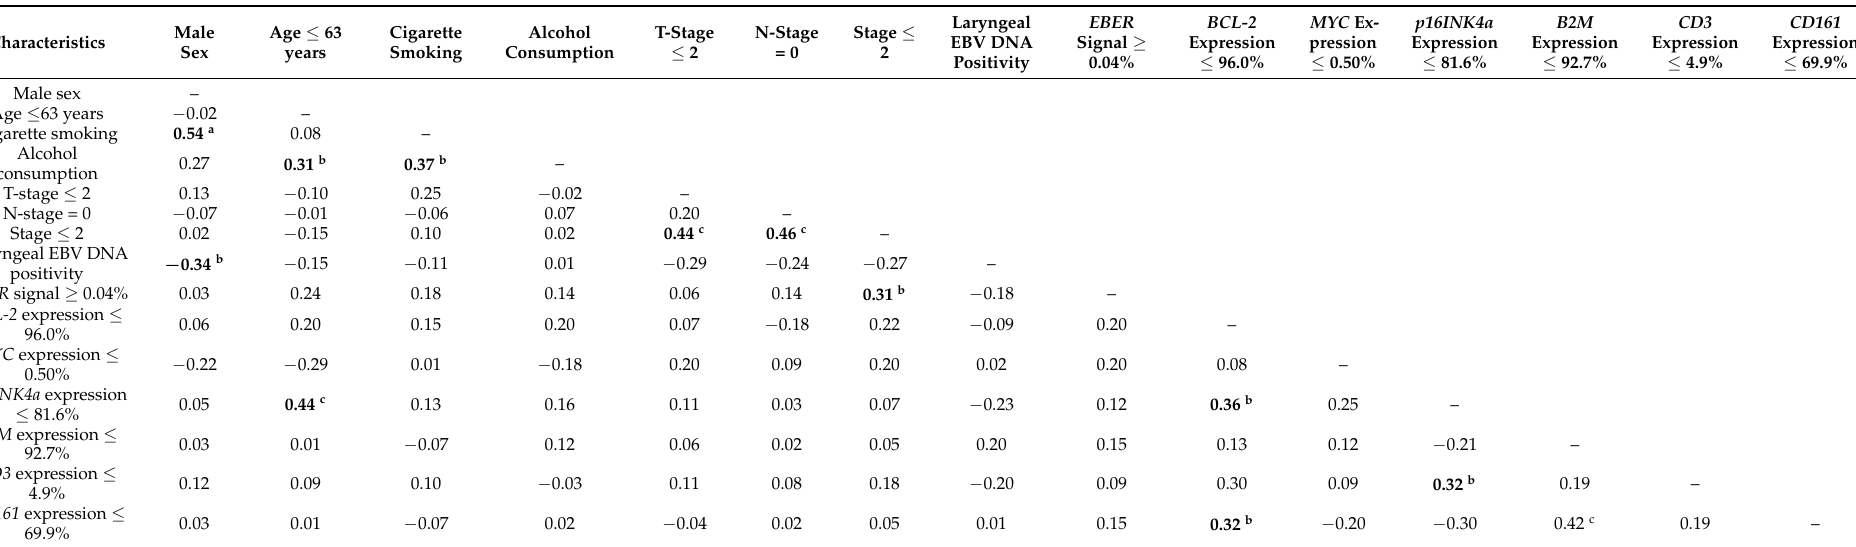
Table 6. Spearman’s correlations between clinical characteristics, laryngeal EBV-related biomarkers, and laryngeal histological characteristics in patients with